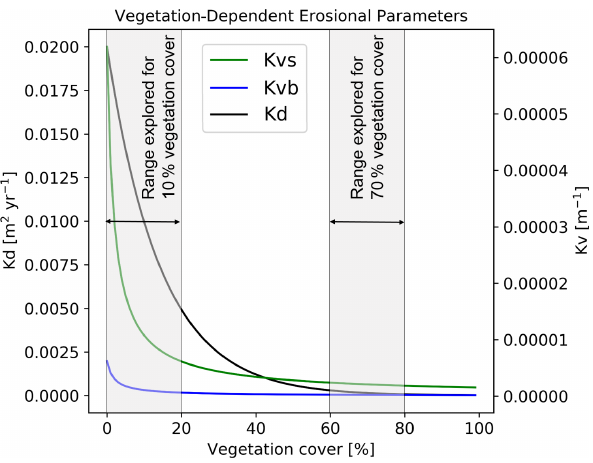
Figure 3. Graphical representation of the range of vegetation- dependent diffusion coefficient ( K d , left y axis), sediment erodi- bility ( K vs ), and bedrock erodibility ( K vb ) values considered in this study (see the Appendix for governing equations). The combined erodibility is referred to as K v (right y